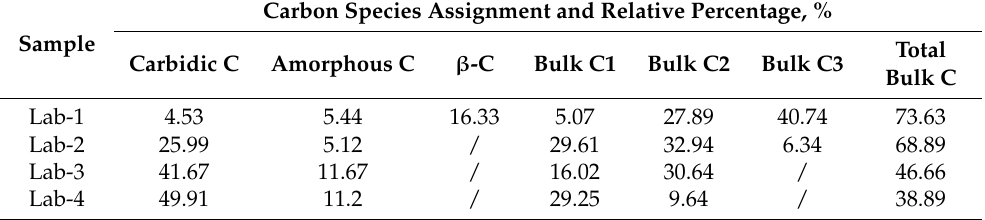
Table 3. Relative contents of carbonaceous species calculated from the corresponding peak area of Gaussian fitting of H 2 -TPH patterns over the catalysts with a different potassium loading.